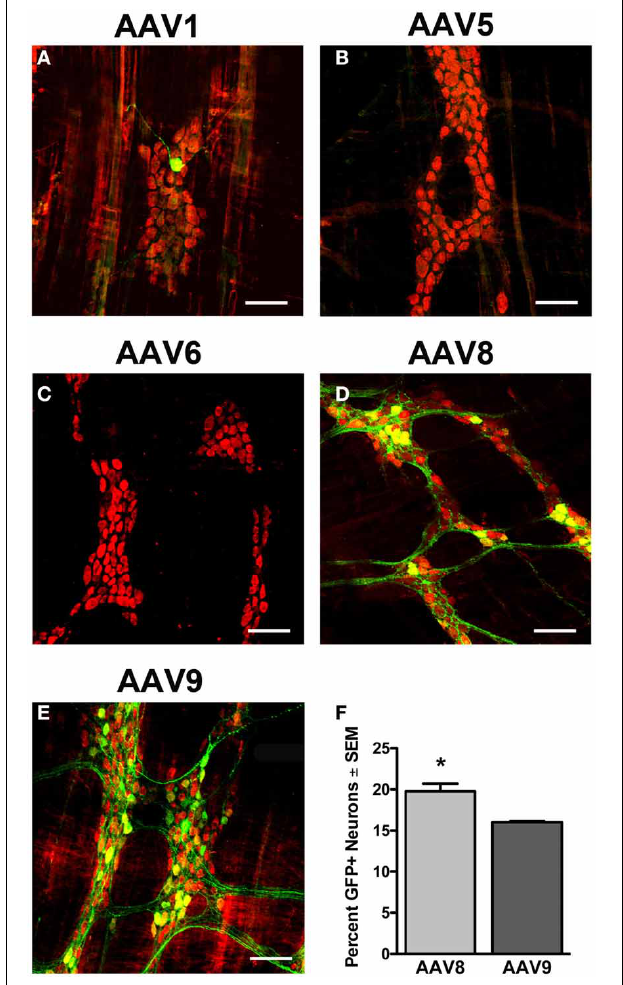
FIGURE 5 | Transduction efficiency in the myenteric plexus is dependent on AAV serotype. Neonatal mice were intravenously injected with scAAV1 (A) , scAAV5 (B) , scAAV6 (C) , scAAV8 (D) , or scAAV9-CB-GFP (E) (final dose 5 × 10 10 vg/ml). Green fluorescent protein (GFP, green) immunofluorescence in the myenteric plexus of the colon reveled absent to minimal GFP expression in neurons (HuD, red) following scAAV1, scAAV5, and scAAV6 intravenous injection. Robust GFP expression was detected in neurons in scAAV8 (D) and scAAV9 (E) injected mice. Total enumeration counts of neurons in the myenteric plexus of the colon revealed that 19.7 ± 0.9% or 16.0 ± 0.2% of neurons were transduced in scAAV8 and scAAV9 injected mice, respectively ( F , ∗ p < 0 . 001). Scale bars are 100 μ